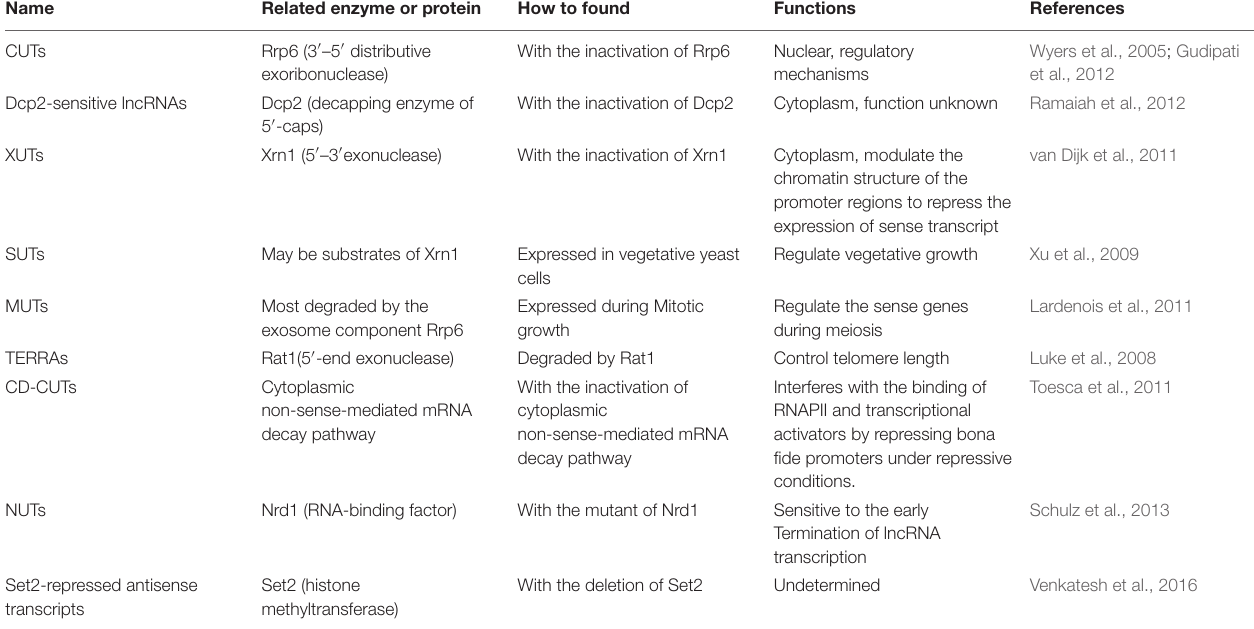
TABLE 1 | Classification of lncRNAs in